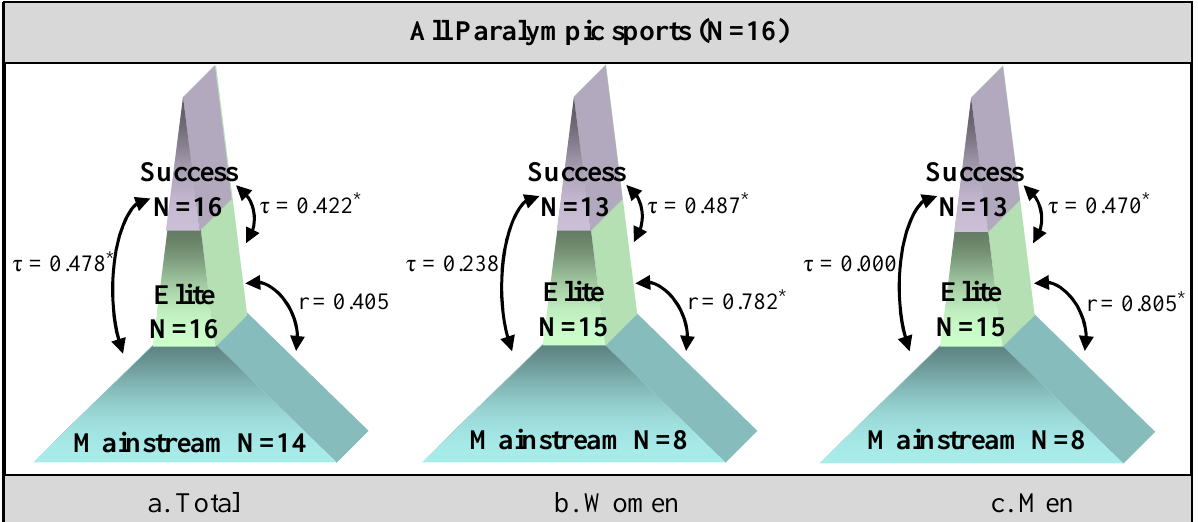
Figure 1. Correlations between mainstream- and elite participation rates and relative Paralympic success. N is the sample size and * indicates p < 0.05. a. Relationships in all Paralympic summer sports. b. Relationships for females in all Paralympic sports. c. Relationships for males in all Paralympic sports.